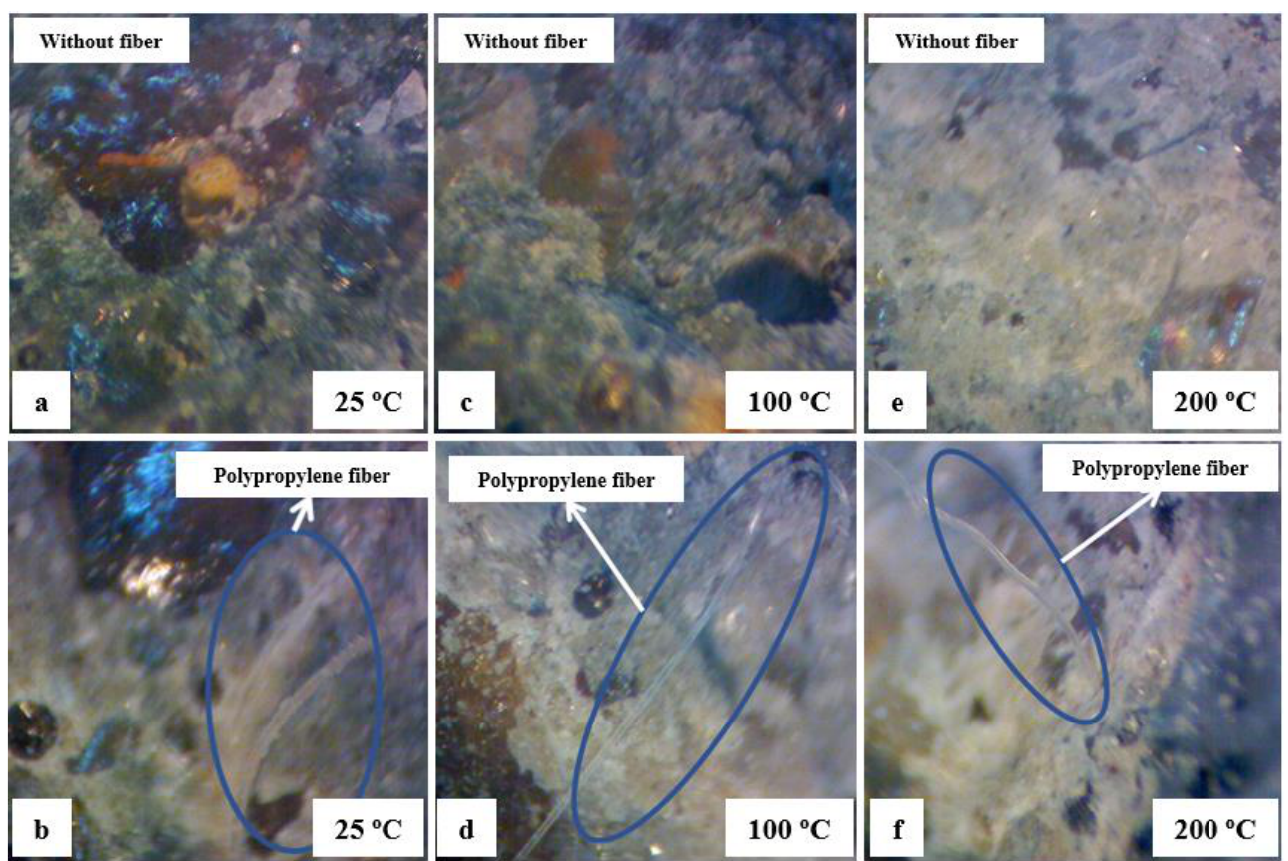
Figure 20. Microstructure of HSC: ( a ) 25 °C without fiber, ( b ) 25 °C with fiber, ( c ) 100 °C without fiber, ( d ) 100 °C with fiber, ( e ) 200 °C without fiber and ( f ) 200 °C with fiber.